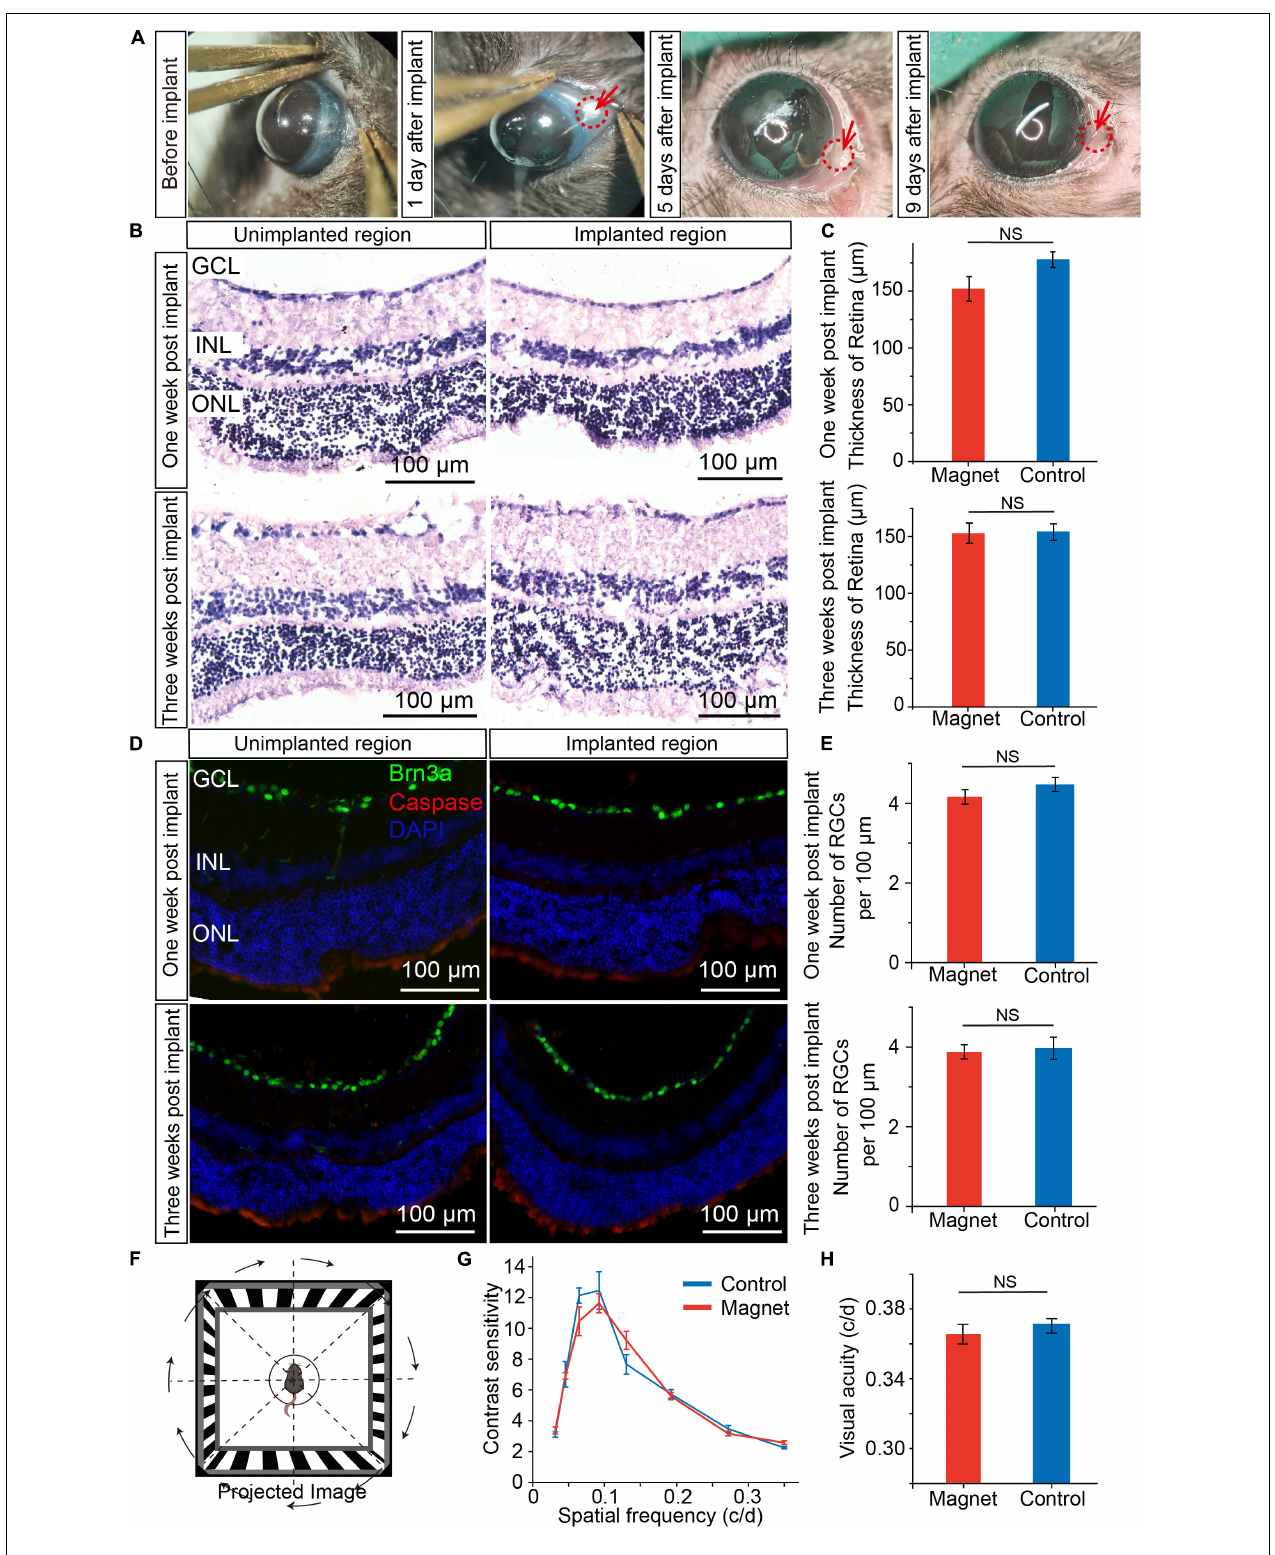
FIGURE 3 | Biocompatibility of magnet implanted in conjunctiva. (A) The corneal status before and after magnet implant in one representative mouse. (B) Representive HE staining of retina sections one/three weeks post implant after magnet implanted. (Left) the region with no magnet implanted; (Right) the